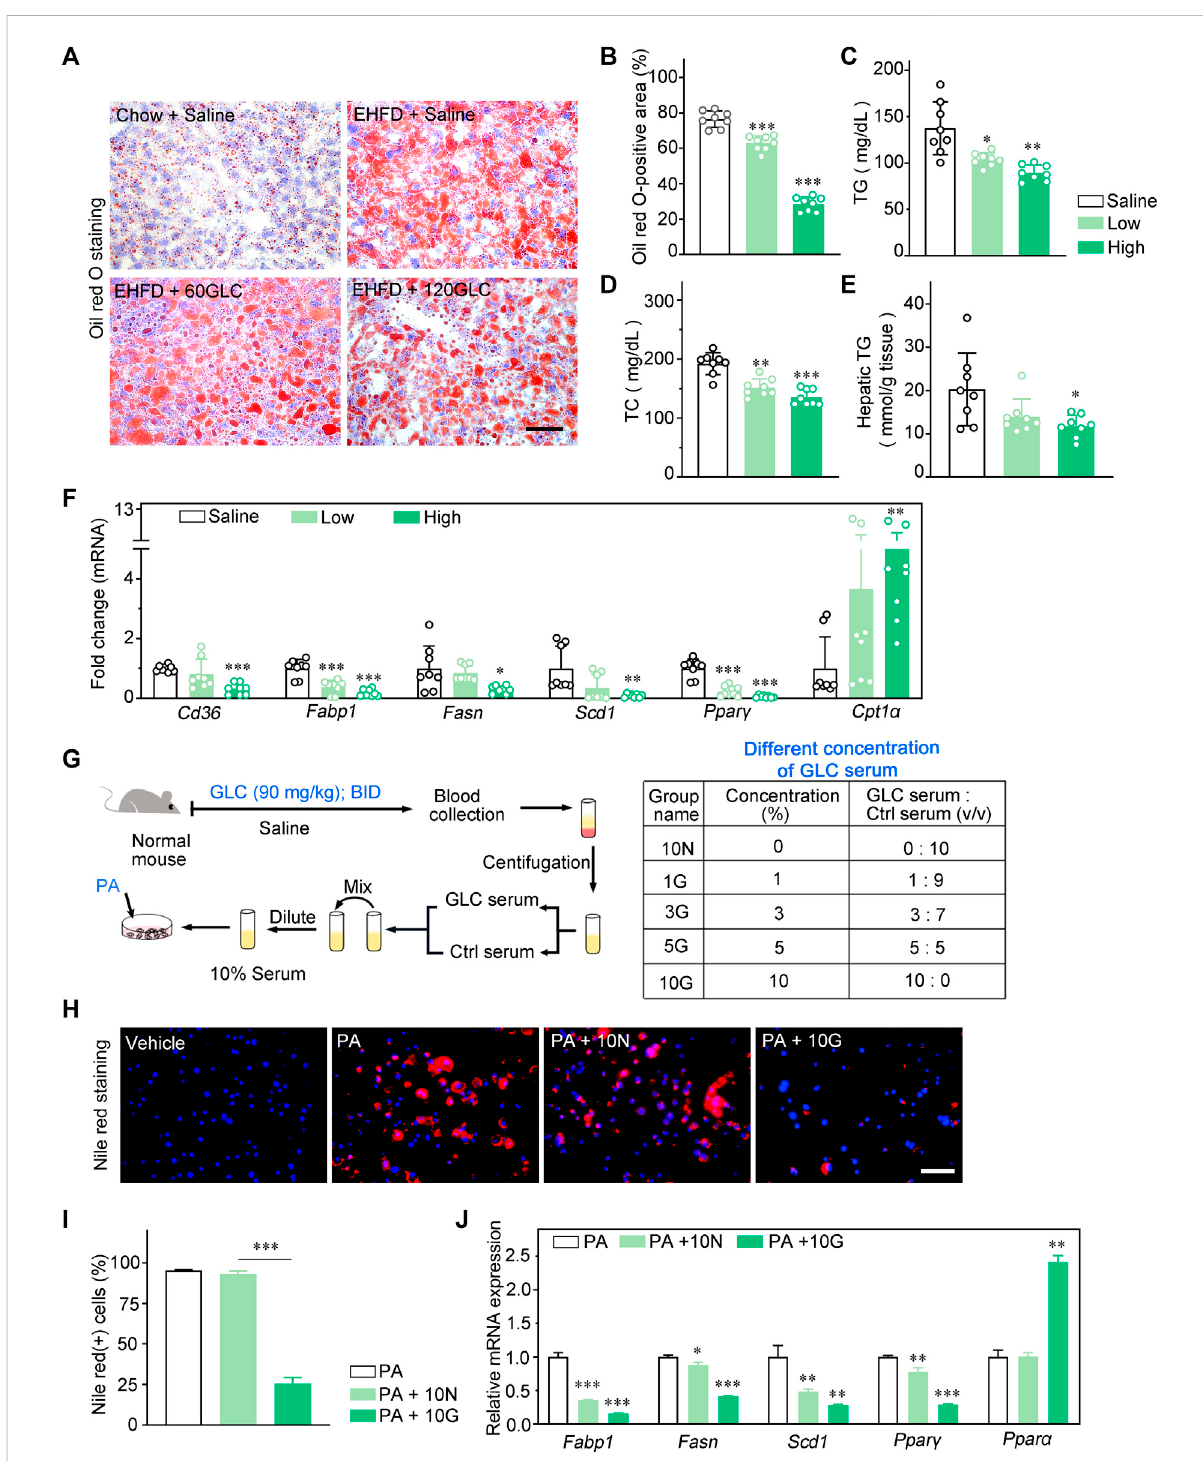
FIGURE 2 GLC alleviates lipid accummulatlon by regulating lipogenesis in vivo and in vitro . (A) Representative images of Oil red O Staining of the frozen liver sections. Scale bars, 50 μ m. (B) The statistics of Oil red O-positive areas. (C) Serum TG and (D) TC levels in EHFD mice. (E) Hepatic TG levels in EHFD mice. (F) Quanttative PCR analysis of the hepatic mRNA levels of genes related to fatty acid metabolism in mice from the indicated groups. Gene expression was nomalized to actin beta (Actb) mRNA levels (n = 8 for each groups). (G) The fl ow chart of drug-containing serum preparation,theGLC-containingserumgroupareshownintable. (H) RepresentativeimagesofnileredstainingofhepatocytesInducedbyEtOHand palmiticacid(PA)withthetreatmentofGLC-containingserum.Scalebars,50 μ m. (I) Thestatisticsofnilered(+)cells. (J) QuantitativePCRanalysisof themRNAlevelsofgenesrelatedtofattyacidmetabolsminhepatocytesinducedbyPAwithdifferentconcentrationsofGLC-containingserum.* P < 0.05; ** P < 0.01; *** P <